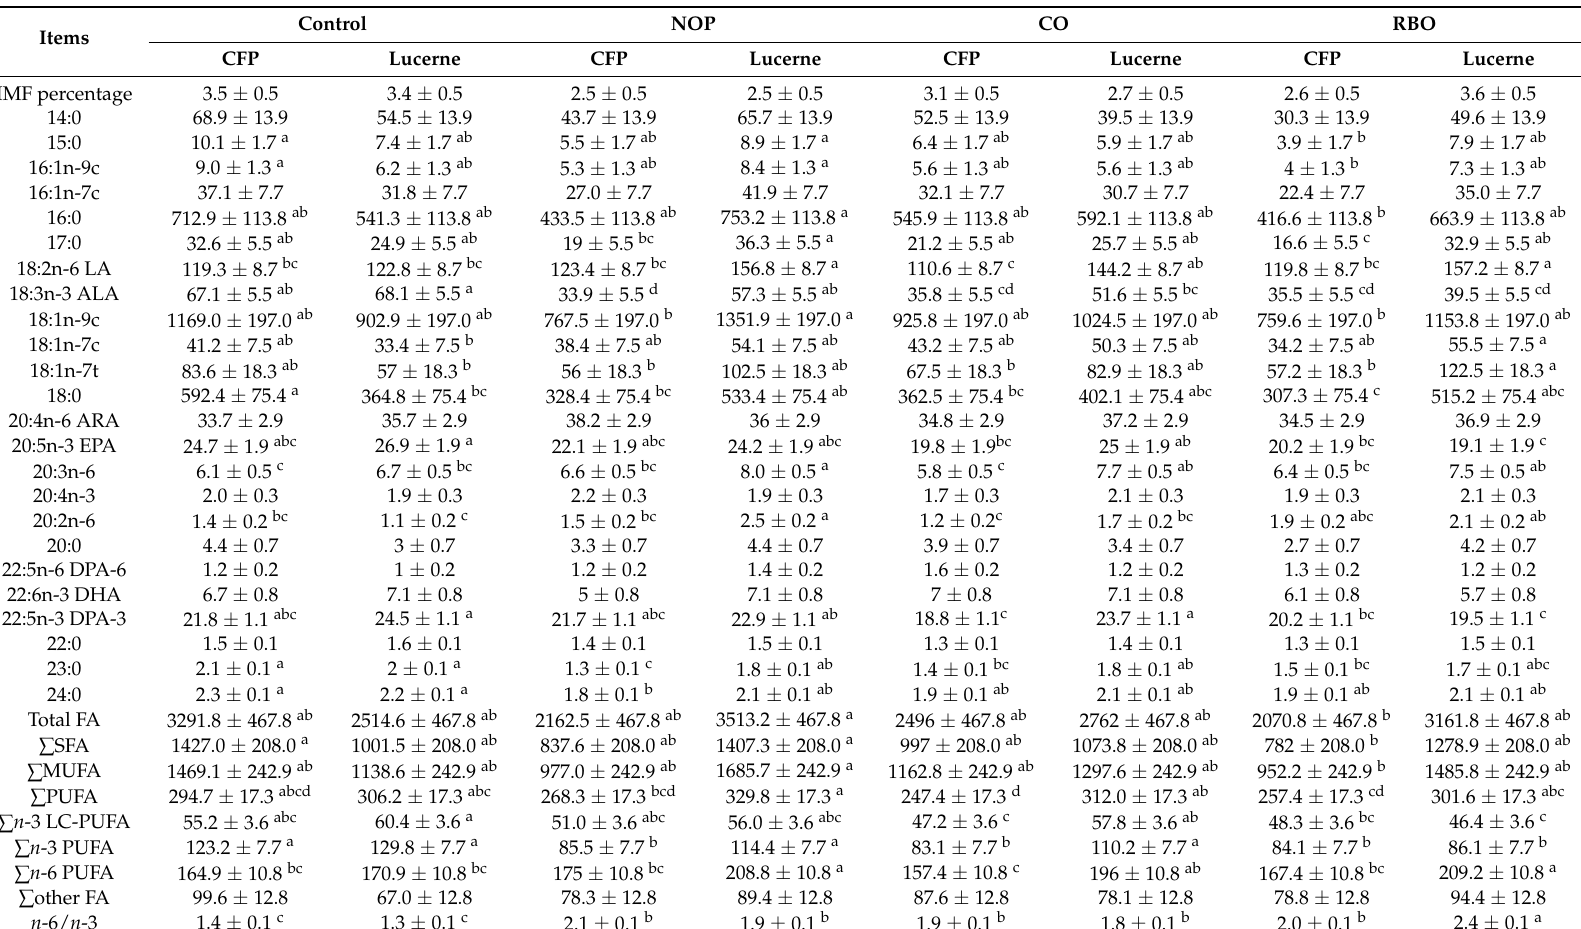
Table 3. Effect of pellet supplementation on IMF percentage (g fat/100 g) and fatty acid contents (mg/100 g) in Longissimus dorsi muscle tissue of grazing prime lambs * (LSM ±